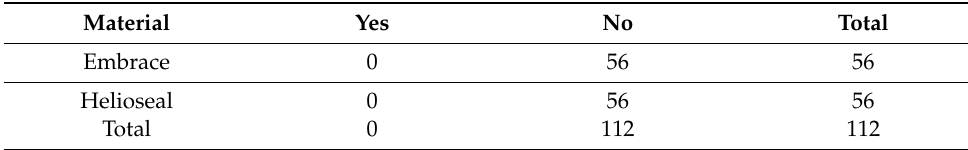
Table 5. Assessment of carious lesion after 6 months.